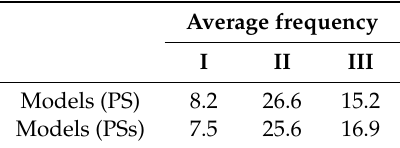
Table 6. Average frequencies of type I, II, and III for models (PS) and models (PSs).